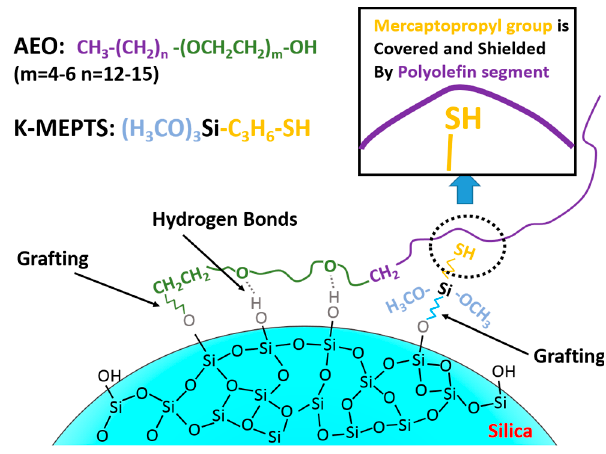
Figure 5. Schematic diagram of the interaction between AEO and K-MEPTS during silica modification.